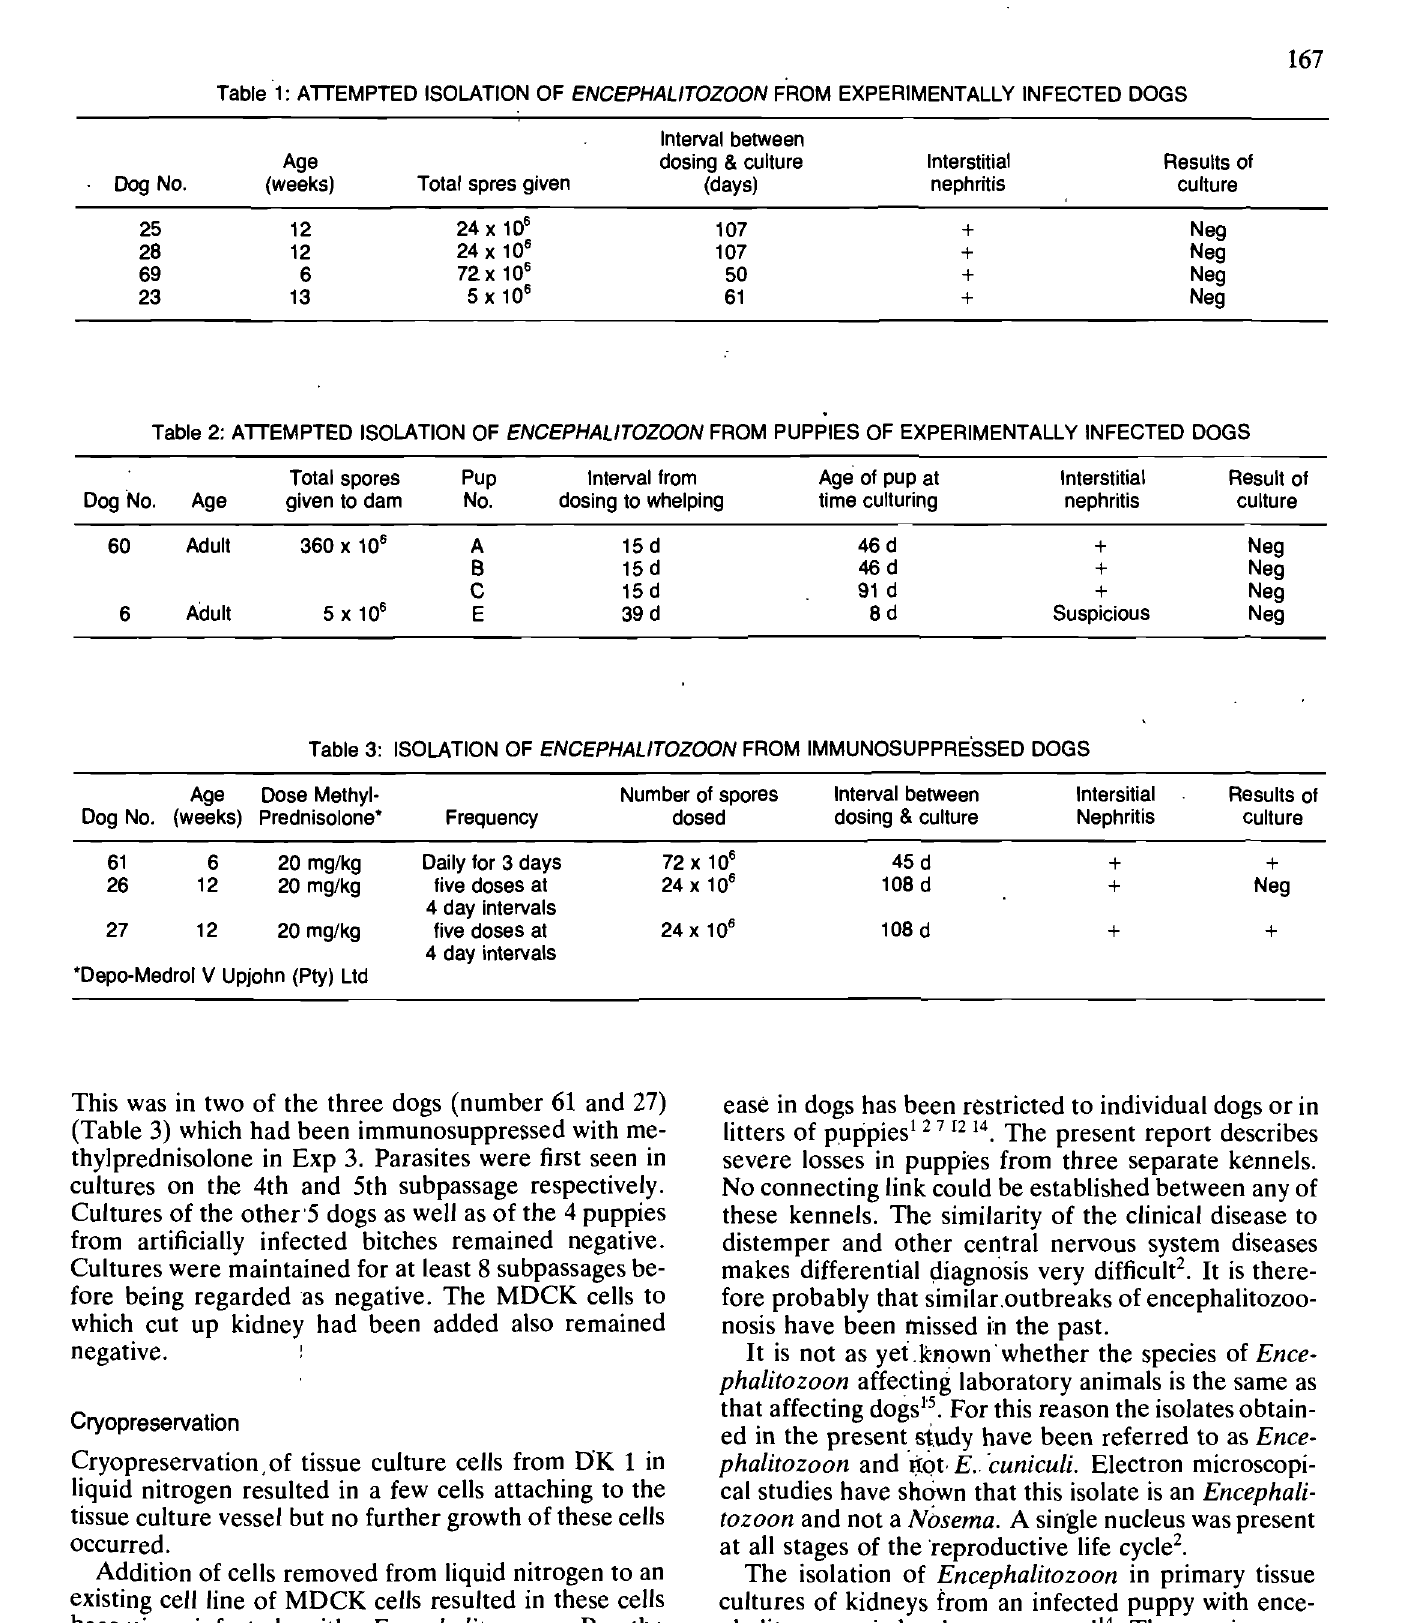
Table 2: ATTEMPTED ISOLATION OF ENCEPHALITOZOON FROM PUPPIES OF EXPERIMENTALLY INFECTED DOGS Total spores Pup Interval from Age of pup at Result of Dog 'No.